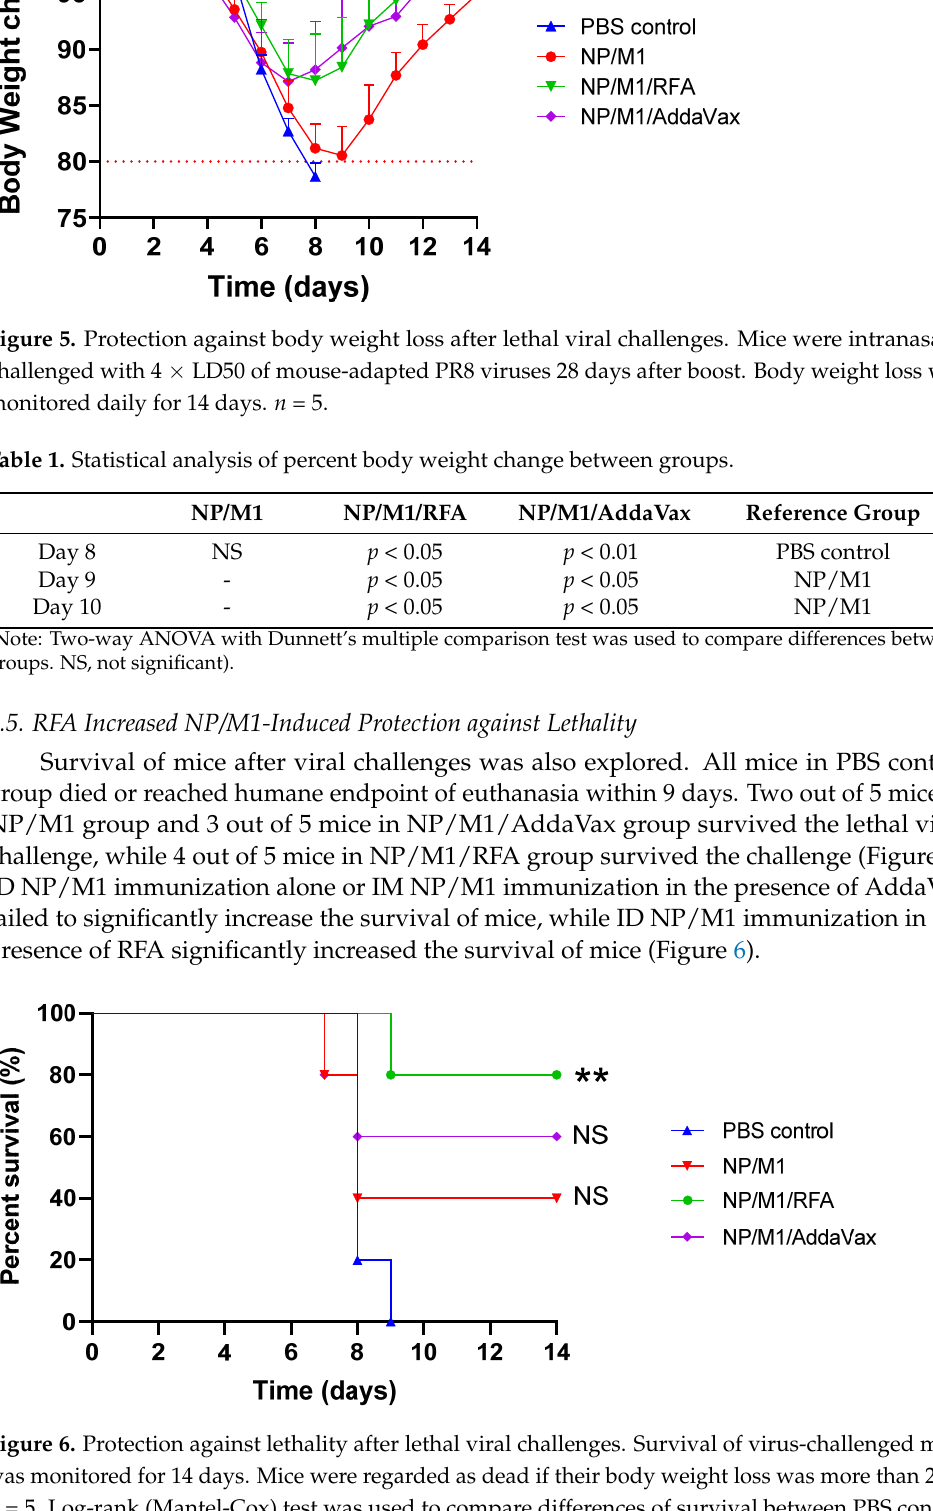
Table 1. Statistical analysis of percent body weight change between groups.